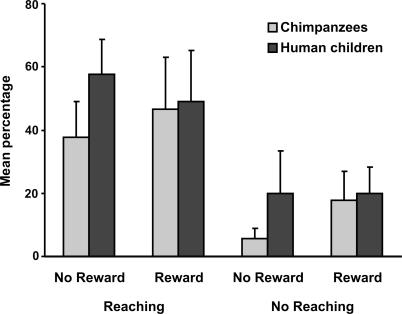
Experiment 1Mean percentage of trials with target behavior (handing the out-of-reach object to the recipient) as a function of species and condition. Error bars represent the standard error of the mean (SEM). Each subject participated in one of the four conditions in a between-subject comparison.